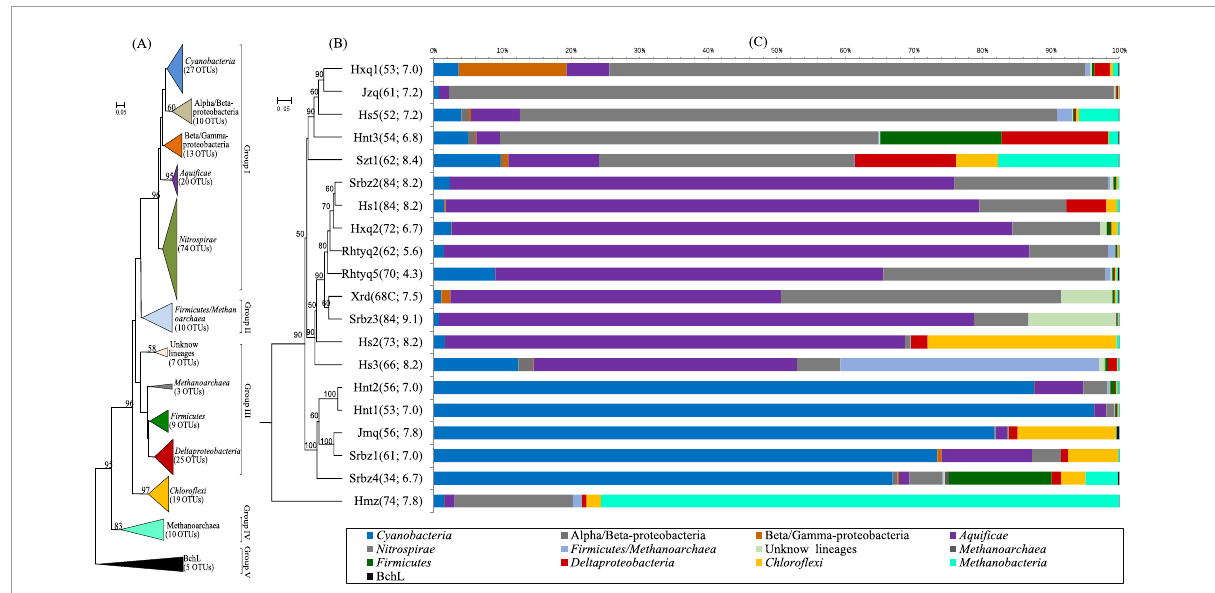
FIGURE2 Phylogenetic analysis, UPGMA analysis and community composition of nifH gene in the investigated hot springs. (A) Neighbor-joining tree showing the phylogenetic affiliation of the OTUs based on protein sequences. Scale bars indicate the Jukes-Cantor distances. Bootstrap values of 50% (for 1,000 iterations) are shown; (B) UPGMA cluster tree based on Bray-Curtis dissimilarity. (C) Compositions of nifH gene. The numbers in the parentheses are the temperature and pH of each site, respectively.